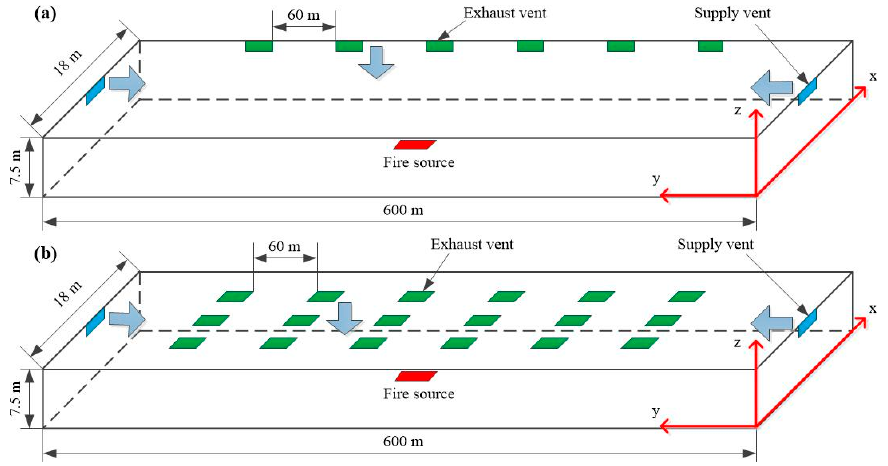
Figure 1. Schematic diagram of tunnel model with different exhaust patterns: ( a ) sidewall; ( b ) top. The fire source was set in the center of the single-bore tunnel (x = 300 m, y = 9 m, z = 0 m). The length and width of the fire source were 5 m and 2 m, respectively, with a surface of 10 m 2 . The tunnel fire was simulated by the burning of diesel, and the chemical formula for fuel was simplified as C 12 H 23 ( C is carbon and H is hydrogen). Previous research [29]